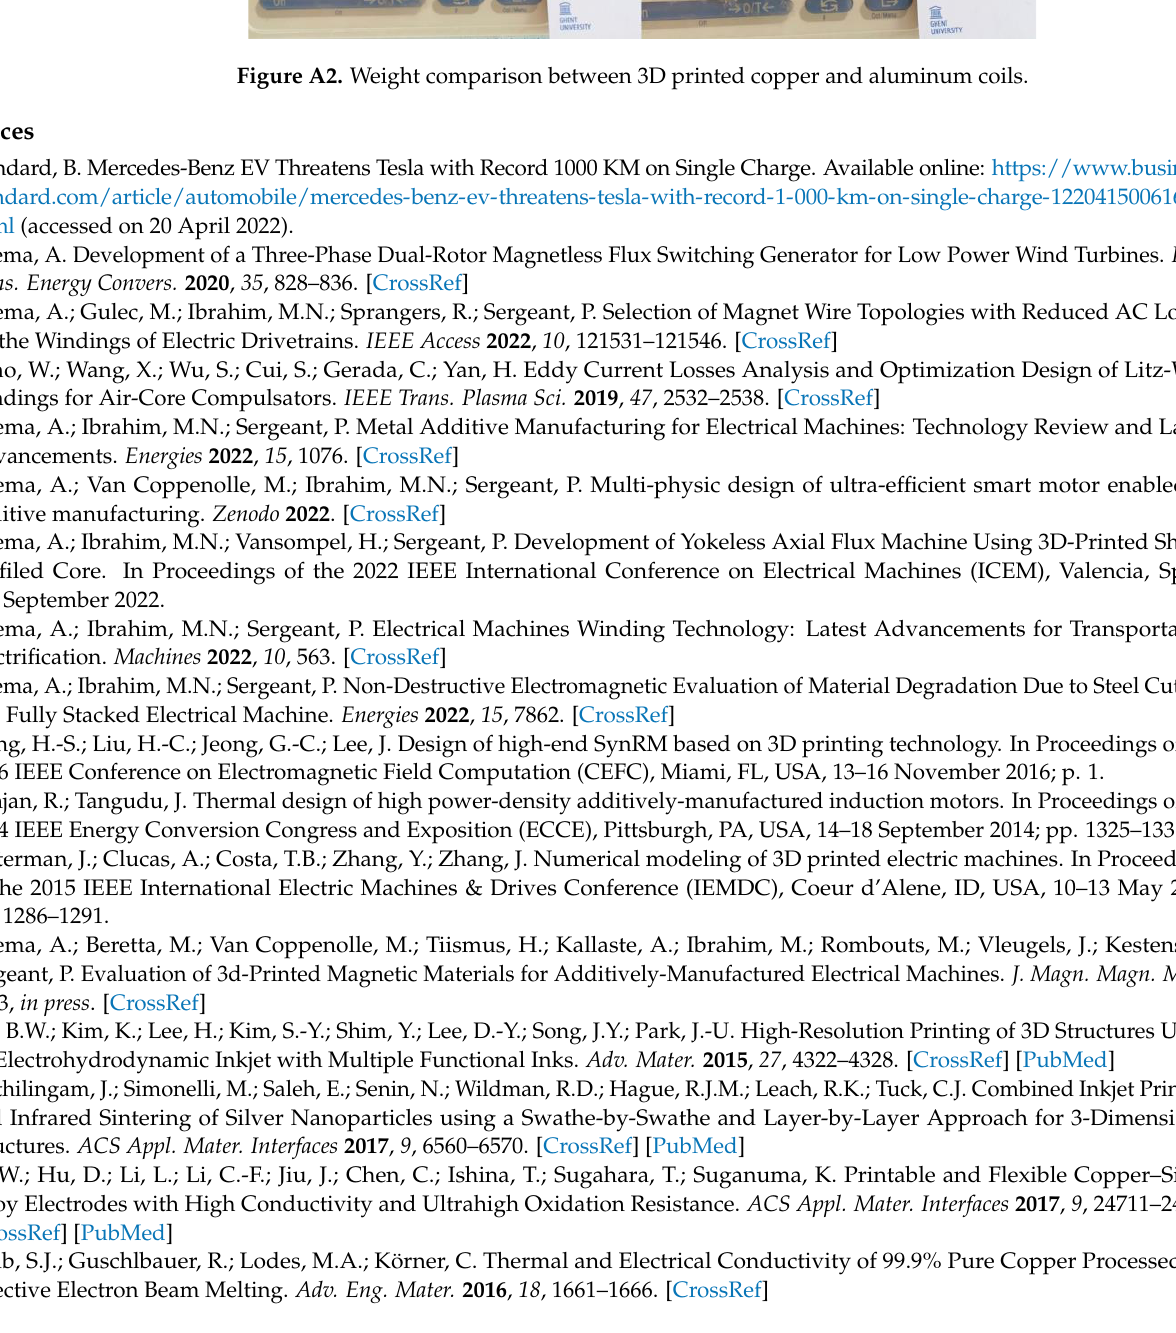
Figure A2. Weight comparison between 3D printed copper and aluminum coils.